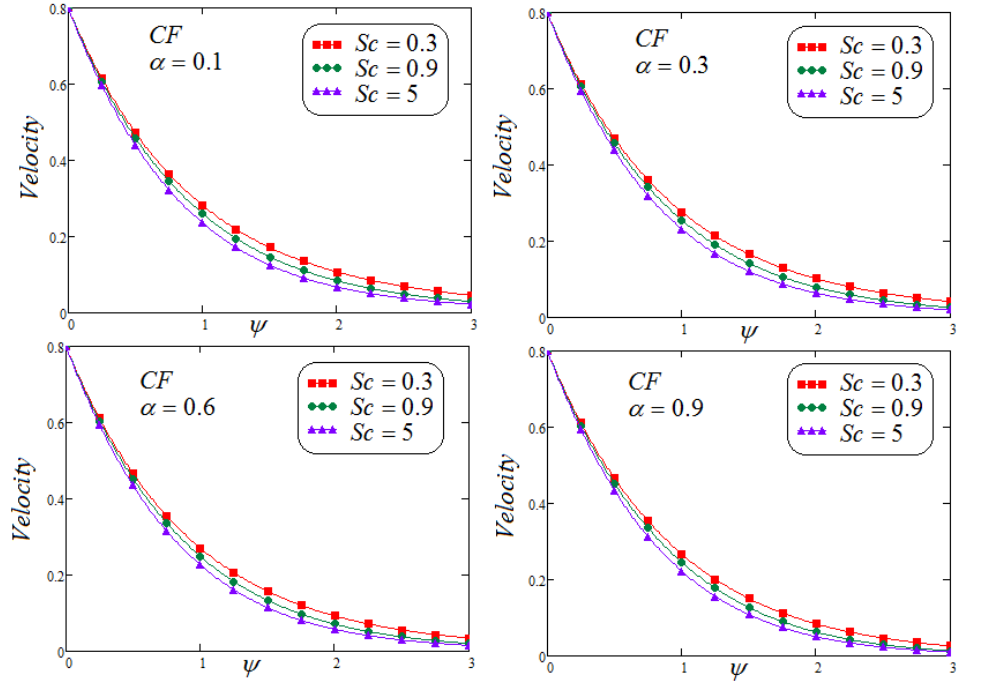
Figure 5. Trace of dimensionless velocity for dissimilar values of Sc via CF.